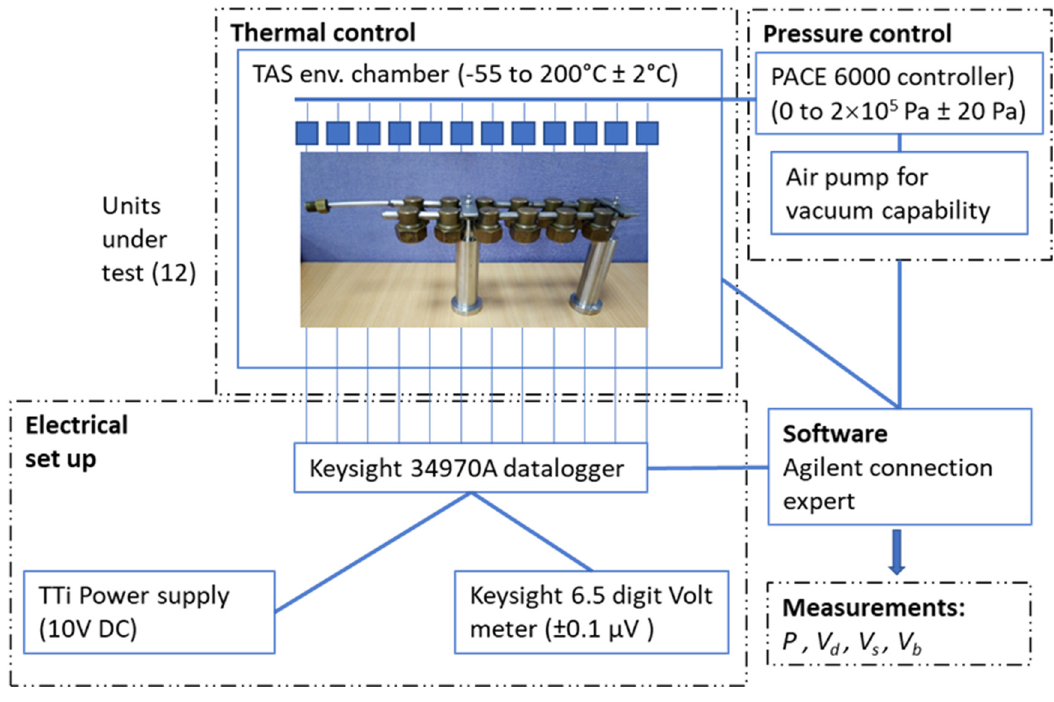
Figure 3. Pressure and temperature cycling test configuration.